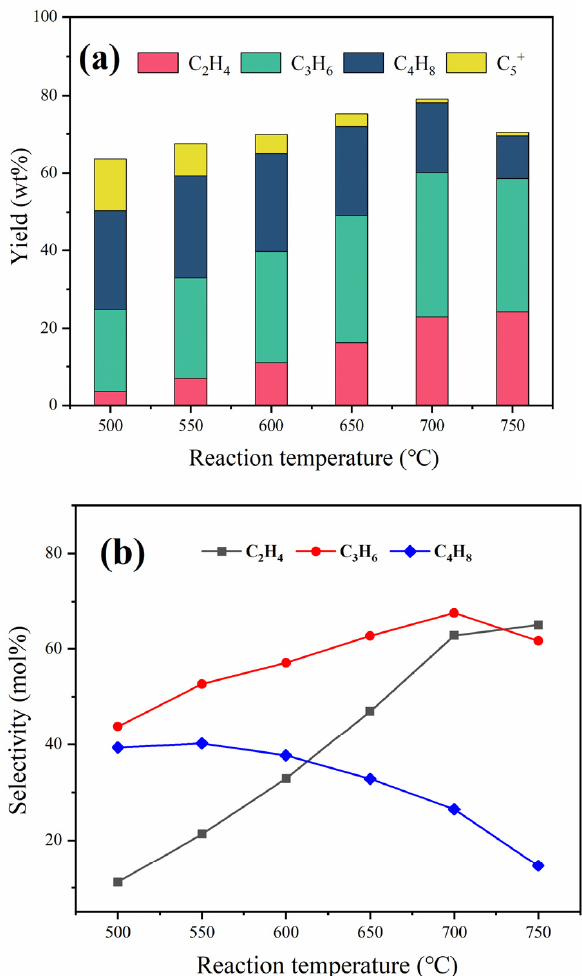
Figure 2. The main product yields ( a ) and selectivities ( b ) from pentene cracking over H-ZSM-5 vs. reaction temperatures. (C 5+ fraction is defined as C 6 –C 10 hydrocarbon which does not include aromatics). Reaction conditions: total pressure, 130 kPa; partial pressure, 60 kPa; WHSV, 83 h − 1 .